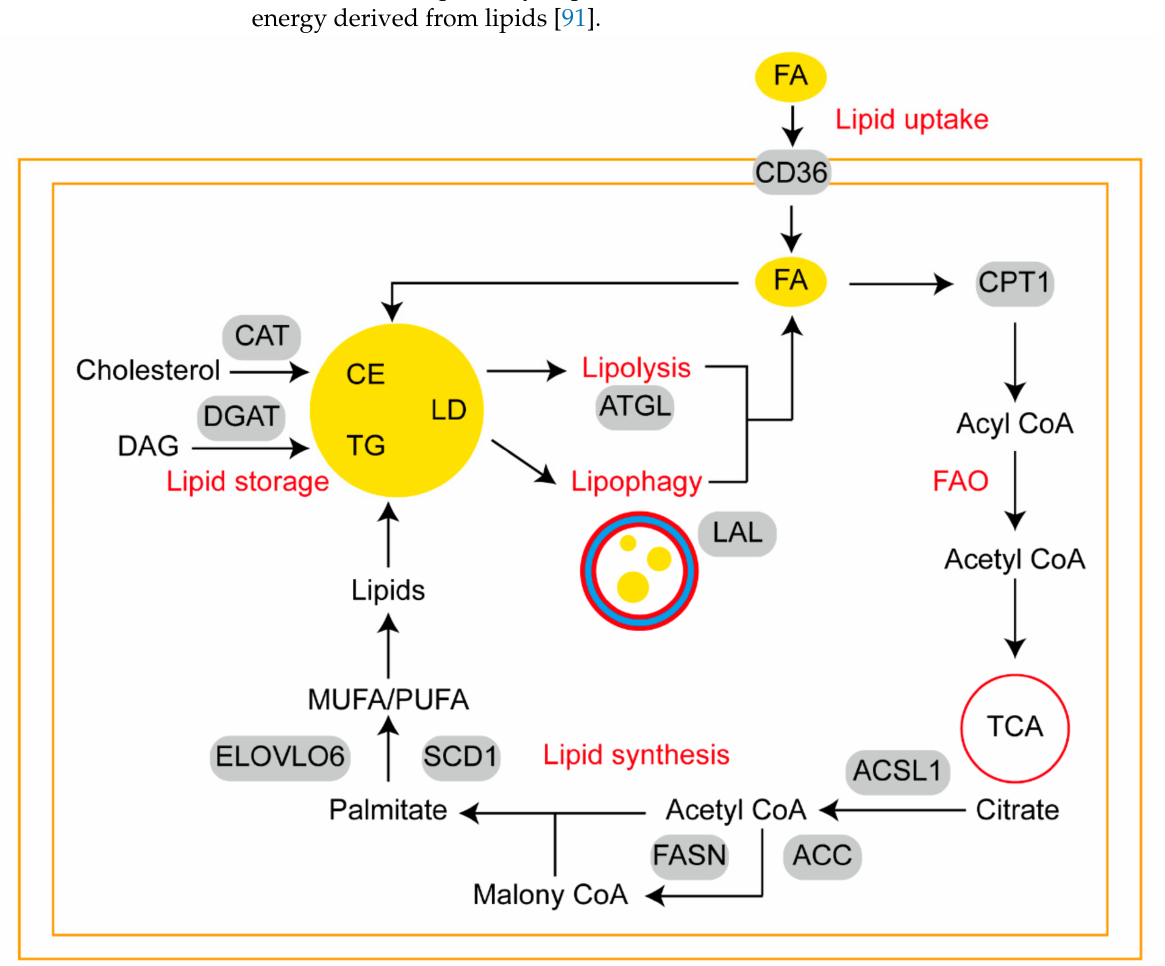
Figure 2. Schematic diagram of lipid metabolism reprogramming in metastatic tumor cells. Extra- cellular FAs could be transported across the membrane by CD36 and FABPs. The entry of FAs into mitochondria for FAO is controlled by CPT1. ACSL1 catalyzes the conversion of citrate to substrates for lipid synthesis. ACC and FASN are key enzymes in the biosynthesis of palmitate. Then, ELOVL6 and SCD1 facilitate the conversion of monounsaturated fatty acid (MUFA) and polyunsaturated fatty acid (PUFA). Excess lipids can be stored in the forms of LD, which cores are CE and TG. Under stress conditions, LDs could be degraded by lipolysis and lipophagy to generate